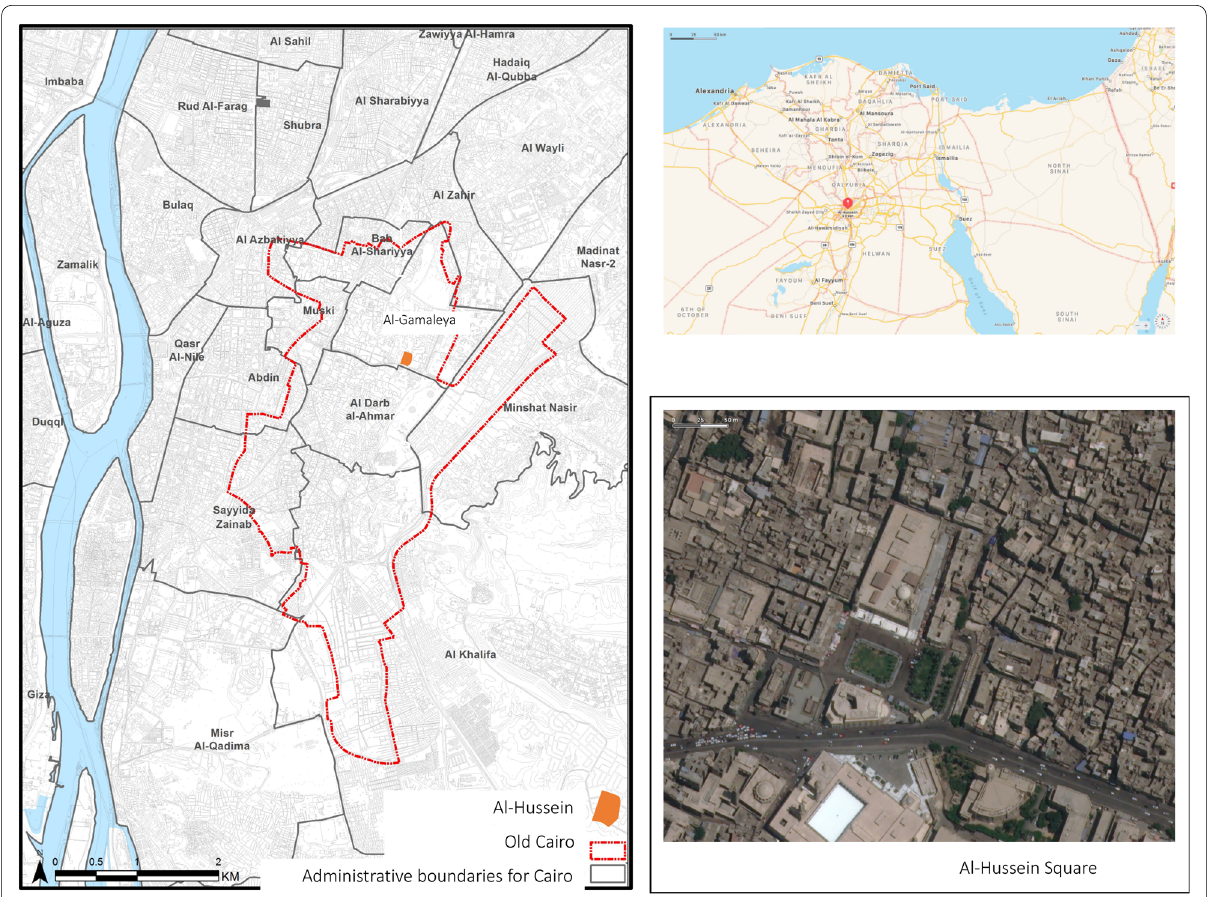
Fig. 3 Location of the case study of Al-Hussein